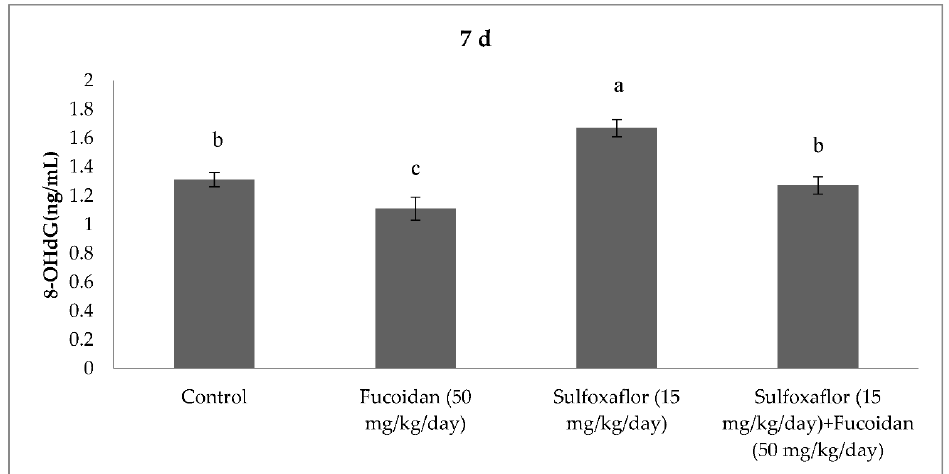
Figure 2. Effects of Sulfoxaflor and Fucoidan on 8-OHdG Levels (ng/mL) in Serum of Mice at 7-d Treatment Periods. Values are expressed as mean±standard error. 8-OHdG: 8-hydroxy-2’-deoxy- guanosine. Letters a, b and c show the differences between treatment groups and control. Data shown in different letters are significantly different at p < 0.05 level ( n = 8). Duncan multiple com- parison tests were used.